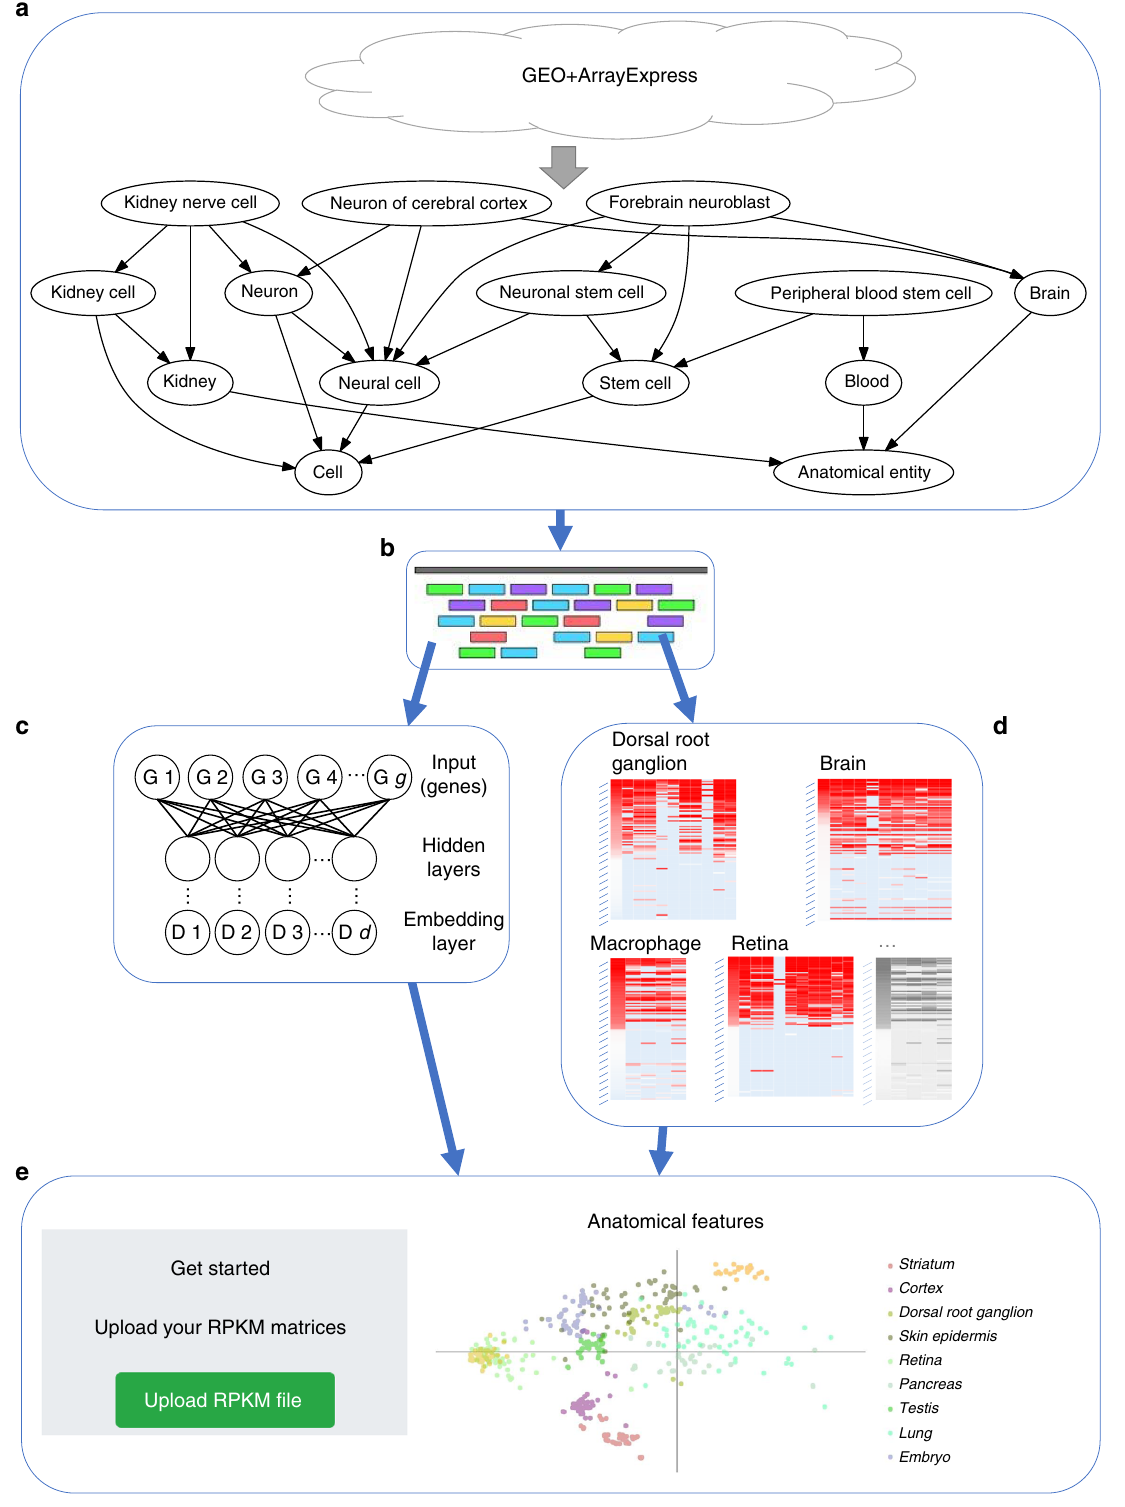
Fig. 1 Pipeline for large-scale, automated analysis of scRNA-seq data. a Bi-weekly querying of GEO and ArrayExpress to download the latest data, followed by automatic label inference by mapping to the Cell Ontology. b Uniform alignment of all datasets using HISAT2, followed by quanti fi cation to obtain RPKM values. c Supervised dimensionality reduction using our neural embedding models. d Identi fi cation of cell-type-speci fi c gene lists using differential expression analysis. e Integration of data and methods into a publicly available web